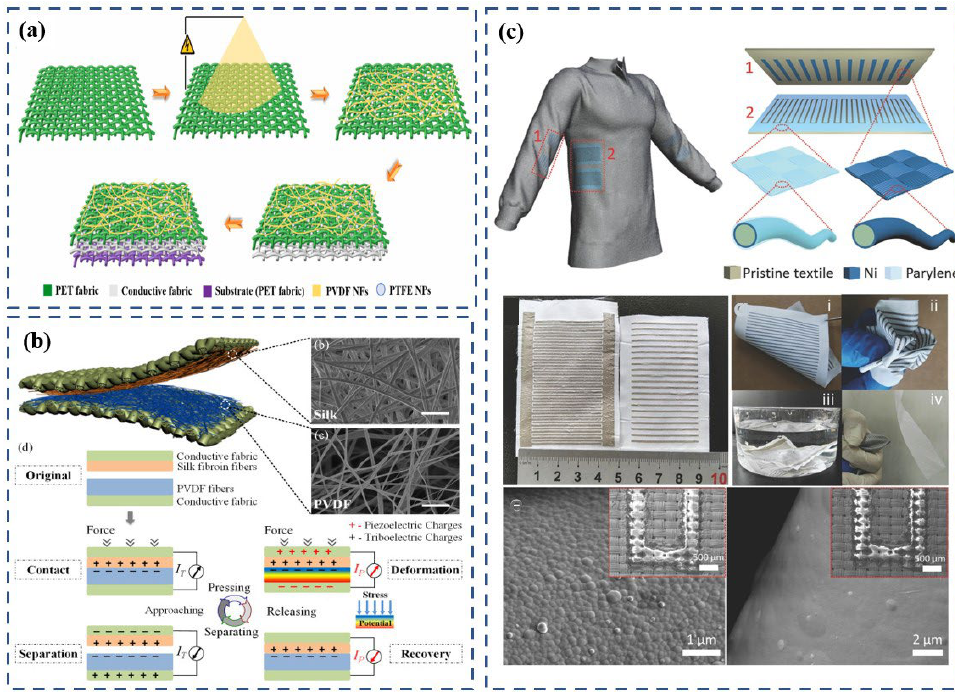
Figure 4. ( a ) Schematic illustration of modified fabrication process of power-generating fabrics. Re- produced with permission [26]. Copyright 2019, Elsevier. ( b ) Schematic diagram of an all-fiber hybrid triboelectric nanogenerator, which consists of two electrodes (conductive fabric) and electrospun silk nanofibers and PVDF nanofibers serving as a triboelectric pair. Schematic view of the operating principle of the hybrid nanogenerator. Reproduced with permission [66]. Copyright 2018, Elsevier. ( c ) Schematic of a power-textile with a pair of TENG fabrics consisting of a slider fabric (1) in the sleeve and a stator fabric (2) underneath the arm. Reproduced with permission [67]. Copyright 2016, John Wiley and Sons.